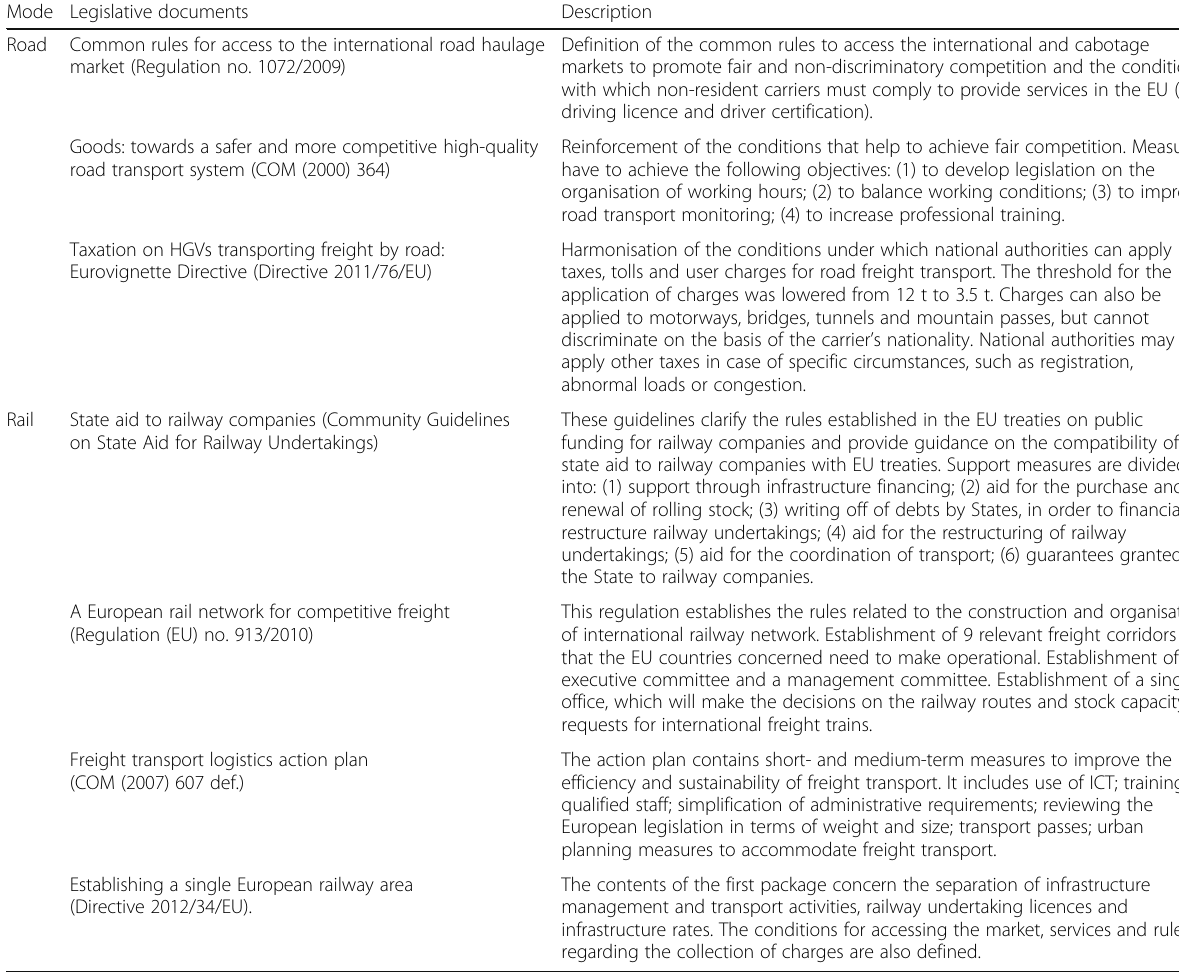
Table 2 EU legislative documents concerning the regulation of road and rail freight transport